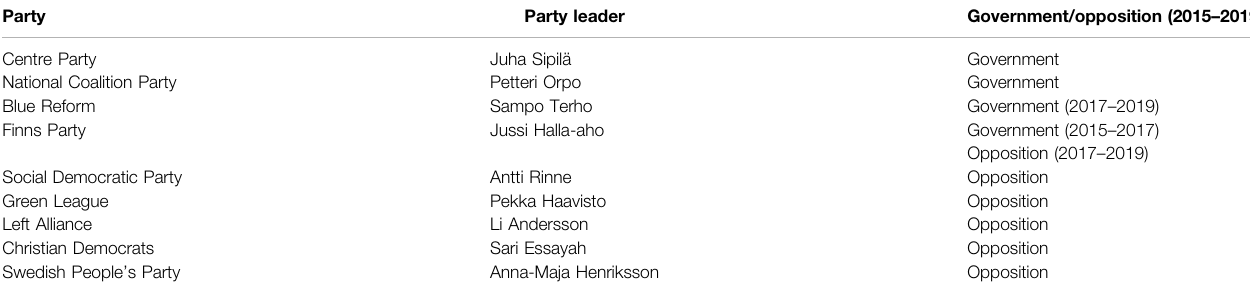
TABLE 1 | Finnish parties and party leaders in the 2015 – 2019 parliamentary term.